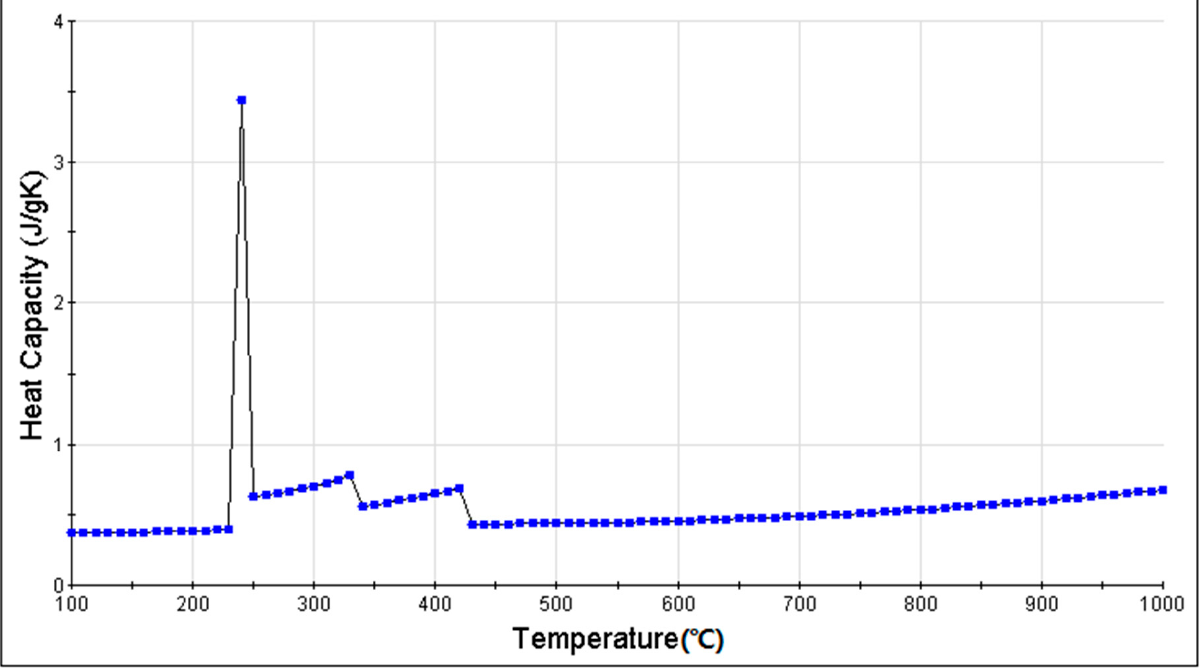
Figure 2. Results of analysis of solidification phases and properties: heat capacity (J/(mole K))–temperature (°C).